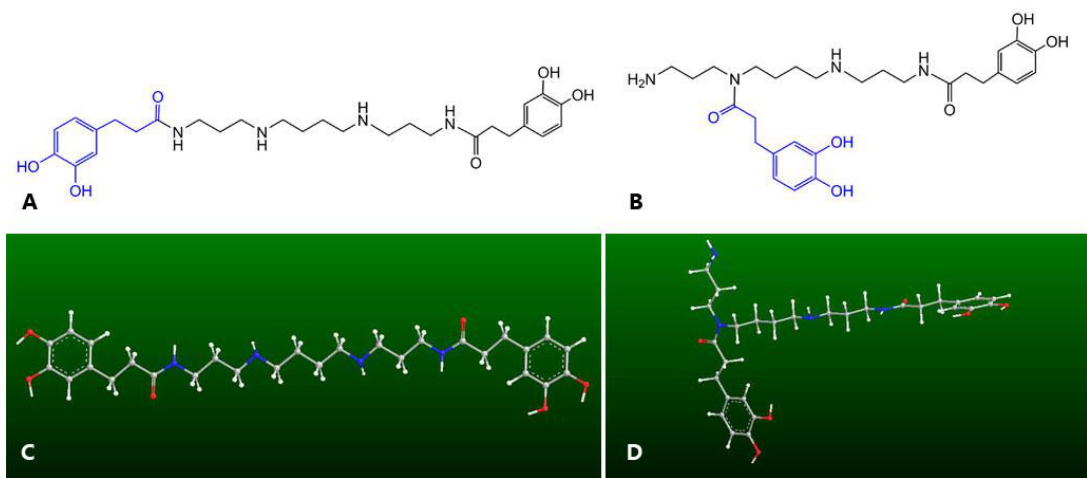
Figure 1. Structures (above) and preferential conformation-based ball-stick models (below) of kukoamine A ( A , C ) and kukoamine B ( B , D ). The ball-stick models were created using Chem3D Pro 14.0.